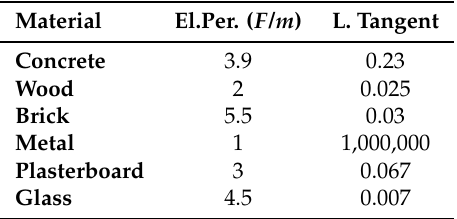
Table 1. Material constitutive parameters of the test